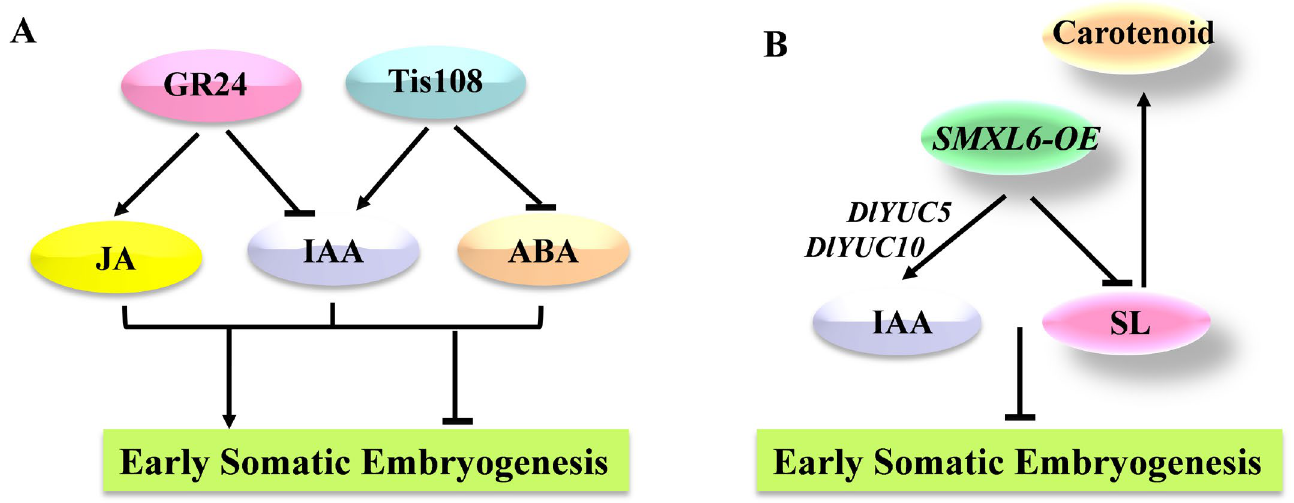
Figure 9. ( A ) The regulation network among GR24 and Tis108 with endogenous hormones during longan somatic embryo development. ( B ) The regulatory network composed of DlSMXL6 during longan somatic embryo development. The arrow indicates promoting the process. The “T” line indicates inhibiting the process.